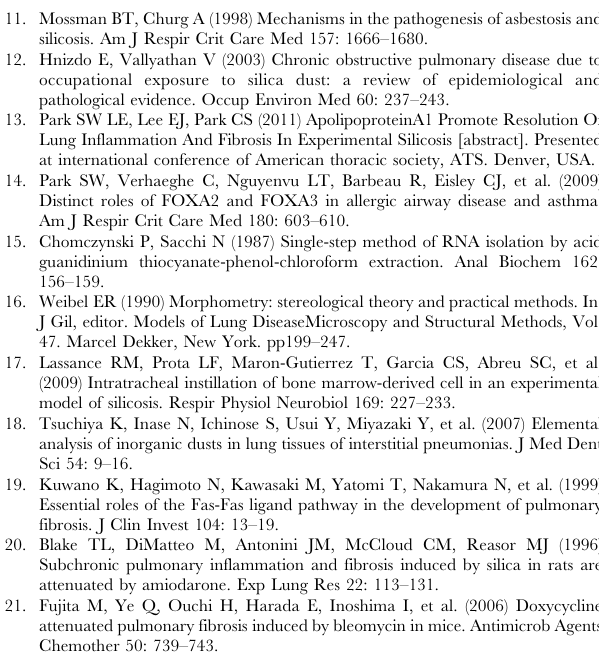
Figure S1 Time courses of endogenous ApoA1 (A), hApoA1 mRNA expression (B) and secreted hApoA1 (C) levels in the lungs of ApoA1 transgenic mice determined by real-time PCR and ELISA, respectively. ELISA was performed on the first 1-mL fraction of BAL fluid, with a detection limit of 3.13 ng/mL (dashed line). (TIF) Figure S2 Localization of apoptotic cells in the mouse lung detected by double-labeled immunofluororescence. Pro-surfactant C (Pro-SPC) and TUNEL stain and merged image (white arrows, double positive cells; 6 100 original magnification). F4/80 and TUNEL stain and merged image (white arrows, double-positive cells; 6 100 original magnification). (TIF) Figure S3 Histological analysis and quantification of lung inflammation and fibrosis in silica administered intratracheally to UBC-GFP transgenic mice that re- ceived doxycycline or distilled water. (A ) Hematoxylin and eosin staining of lung sections. Scale bar= 20 m m (B ) Differential cell counts from BAL fluid. ( C) Quantification of the area occupied by silicotic nodules in the lung ( n =6/group). (D) Quantification of the soluble lung collagen amounts using a Sircol assay.